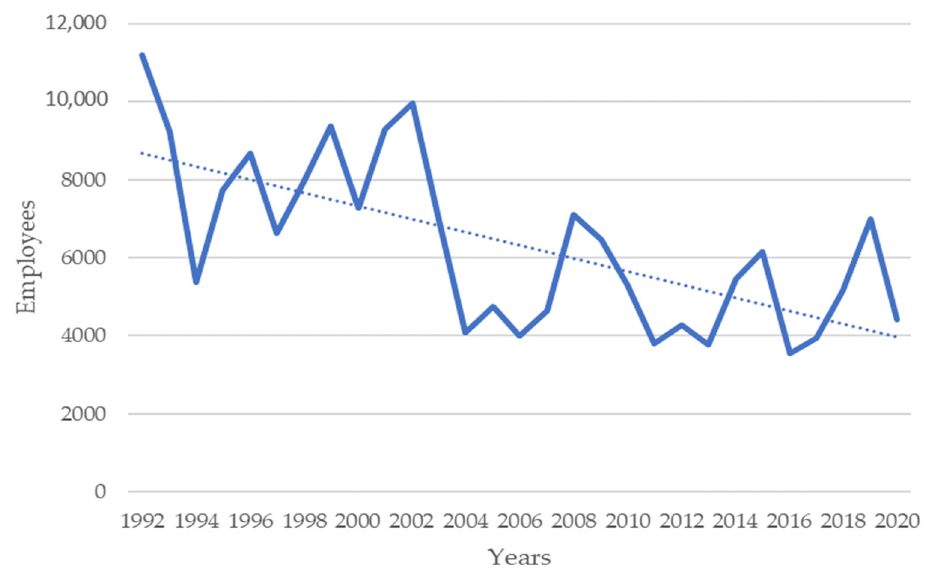
Figure 2. Employment in forestry and logging for Greece. Source: Authors’ own work, based on FAO data [(https://www.fao.org/faostat/en/#home (accessed on 24 September 2022)].